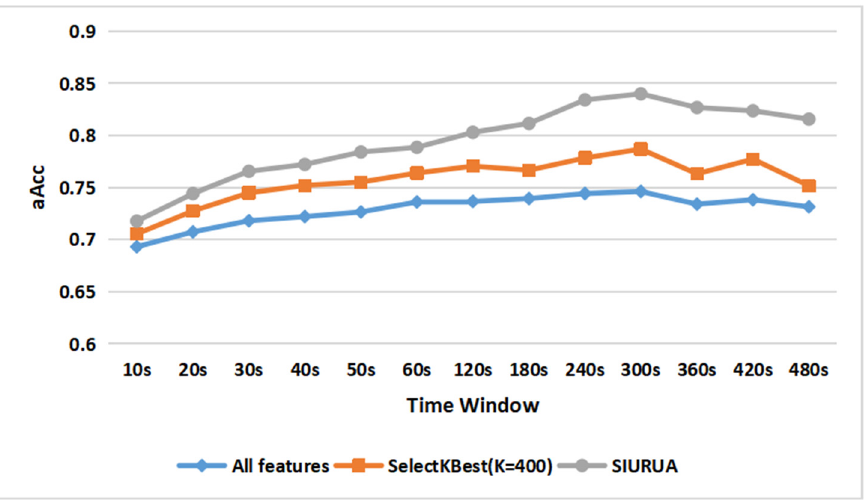
Figure 10. Comparison of accuracy between SIURUA and selecting 400 best features in a hybrid scene.